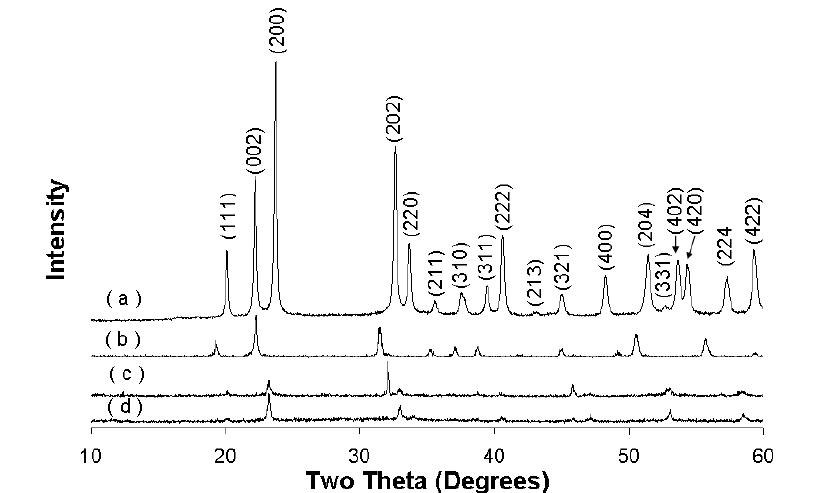
Figure 2. XRD of MSn(OH)